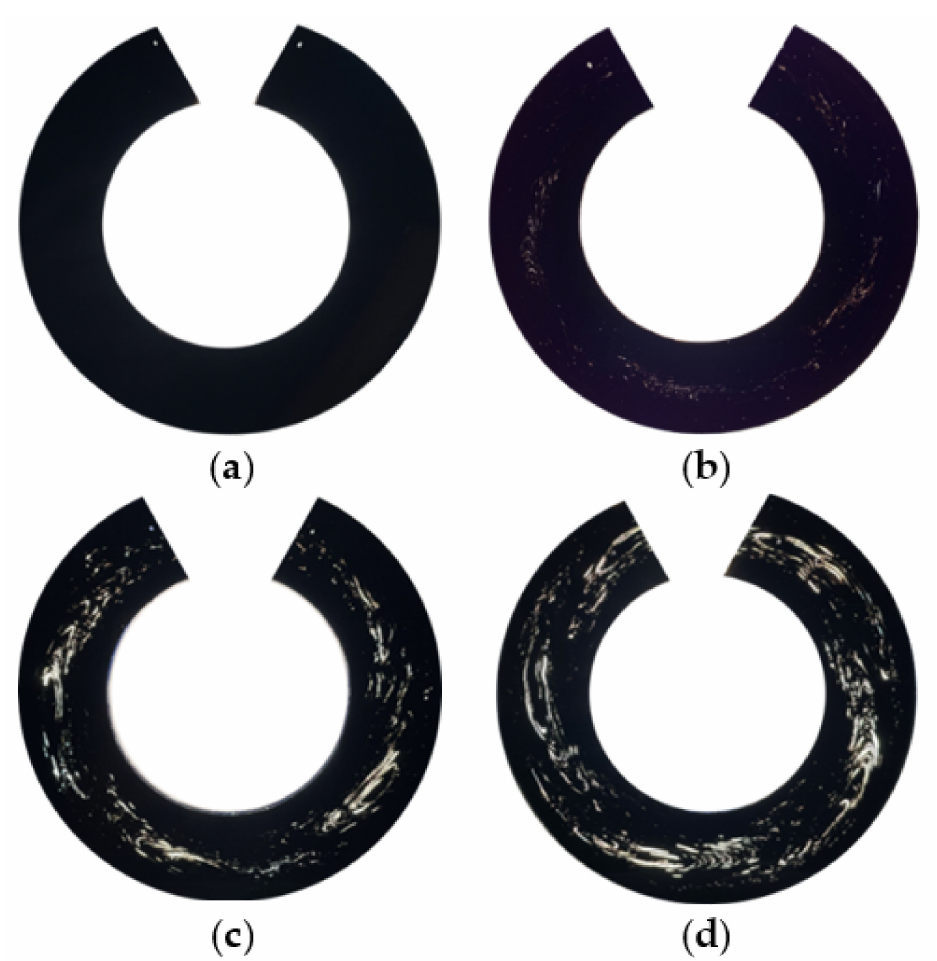
Figure 9. Whole pipe cross-section shavings under cross-polarized monochromatic light. ( a ) Sample 1, ( b ) sample 2, ( c ) sample 3, and ( d ) sample 4. The % windows of shavings determined using the monochromatic cross-polarized light are shown in Figure 10. The mean % windows were found to be 0%, 1.5%, 7.5%, and 16.5%, for samples 1, 2, 3, and 4, respectively.